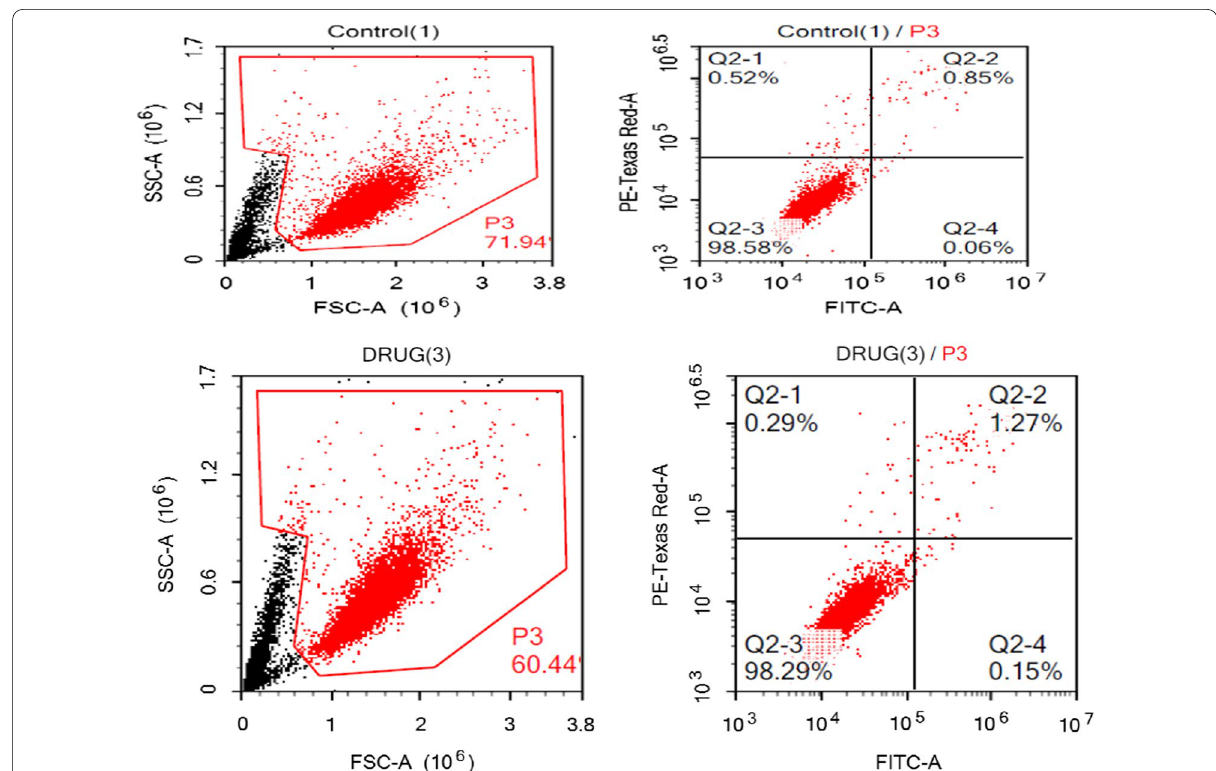
Fig. 6 Flow cytometry for apoptosis analysis of cultured HNO97 cells treated with apricot oil